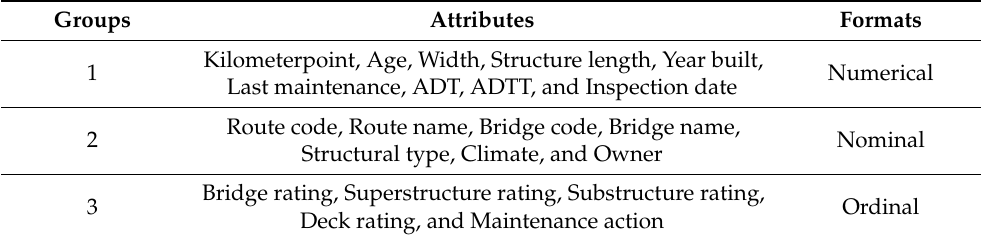
Figure 4. Data extraction and integration flow chart. Table 1. Typical attributes of a bridge network.